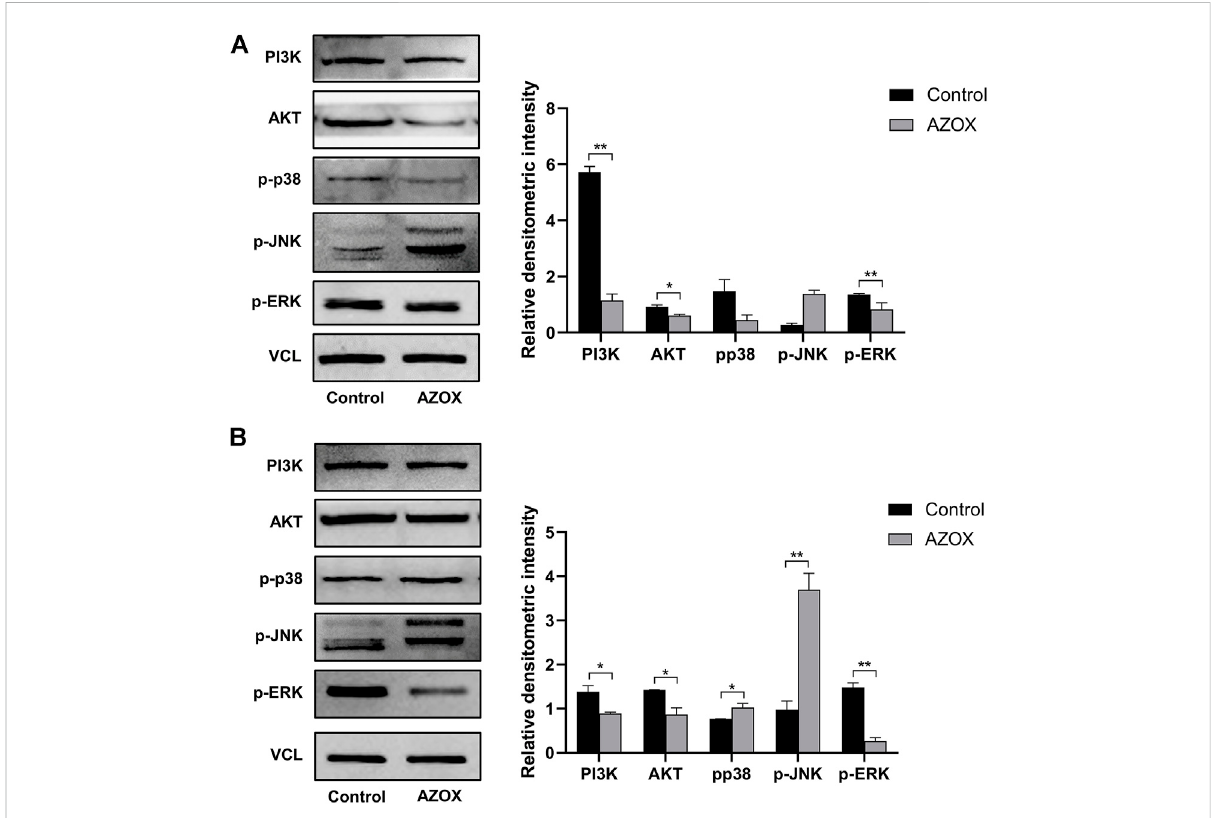
FIGURE 6 AZOX induces apoptosis via MAPK and PI3K/AKT pathways in DOK cells. (A) The expression of PI3K, AKT, and MAPK pathway relative markers p-ERK,p-JNK,p-p38inDOKcellsafterbeingtreatedby10 μ g/mlAZOXfor24 h (B) TheexpressionofPI3K,AKT,andMAPKpathwayrelativemarkers p-ERK, p-JNK, p-p38 in DOK cells after being treated by 10 μ g/ml AZOX for 48 h. * p < 0.05, ** p <